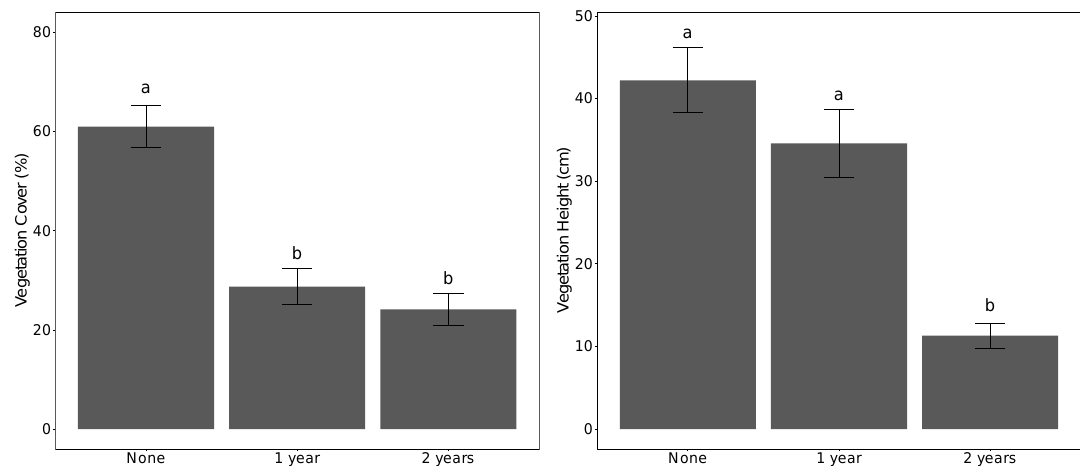
Figure 3. Mean ± SE cover (%) and height (cm) of competing vegetation in a 1-m 2 survey around Q. virginiana seedlings. Seedlings were planted in fenced or non-fenced plots and competing vegetation was not removed or removed for one year or two years. Different letters indicate significant differences for each main effect, fencing and vegetation control ( α = 0.05).